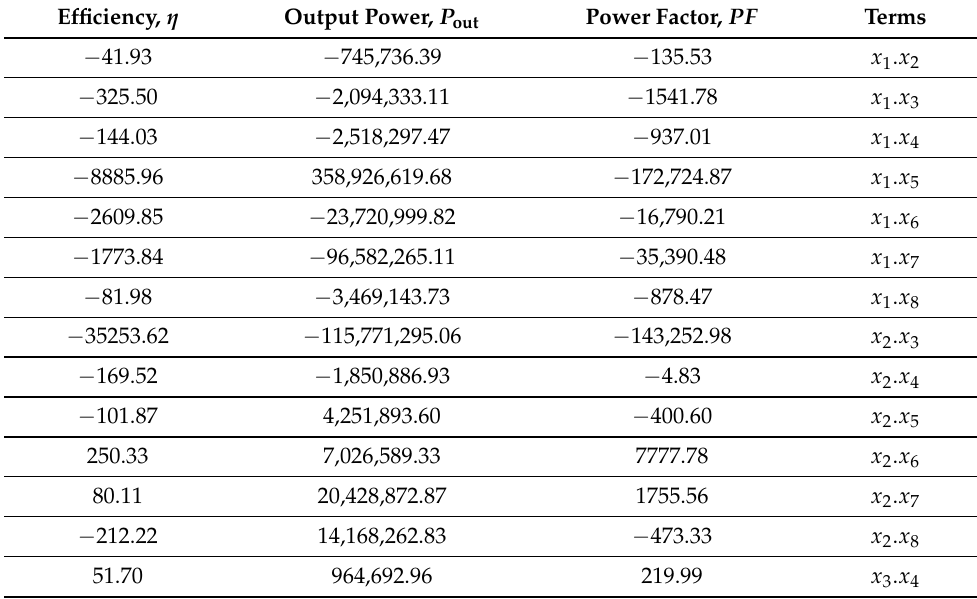
Table A3. Quadratic closed form equation of Box–Behnken design—second-order product